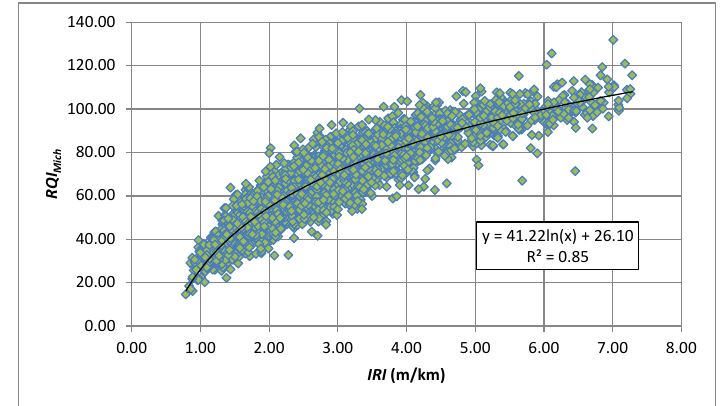
Figure 13. Correlation between RQI Mich and IRI .